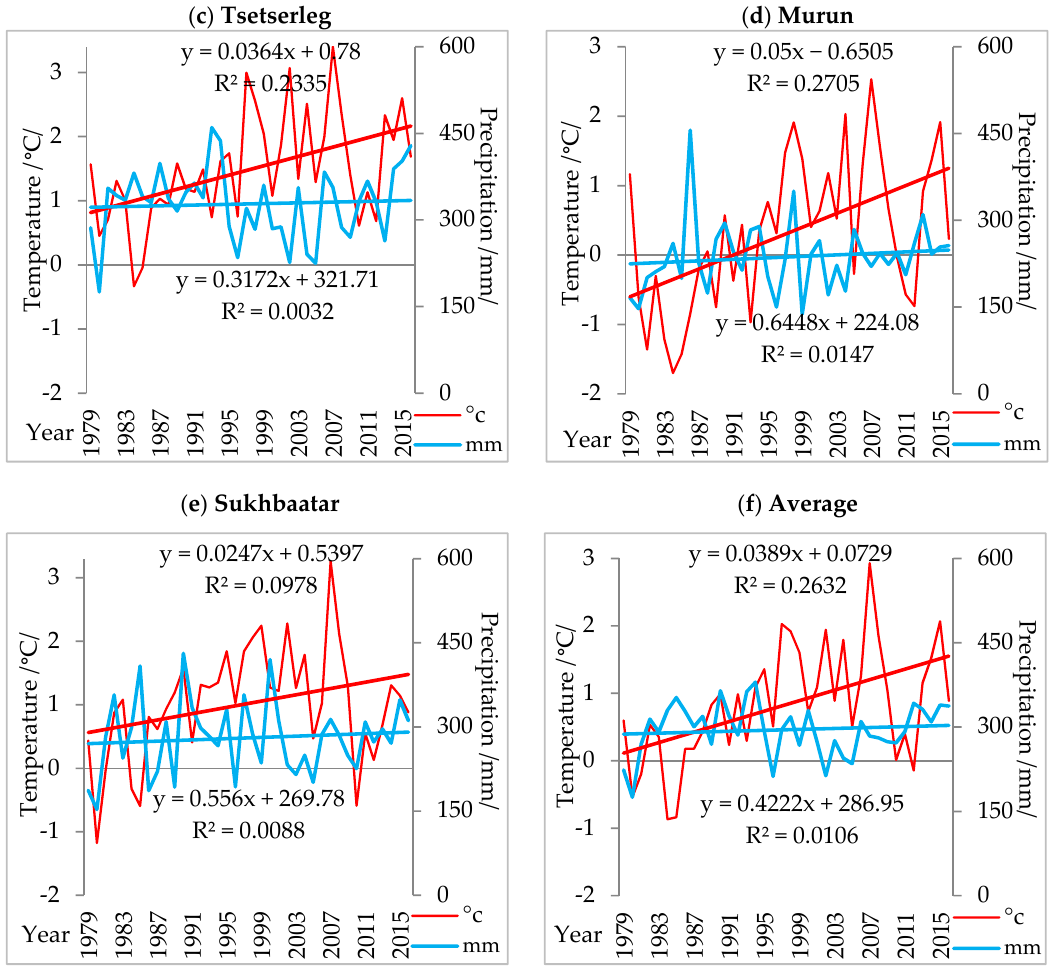
Figure 6. The air temperature and precipitation trend for the period 1979–2016. The vertical column is air temperature and precipitation change, and fluctuations line indicates annual values and solid lines indicate period running averages.